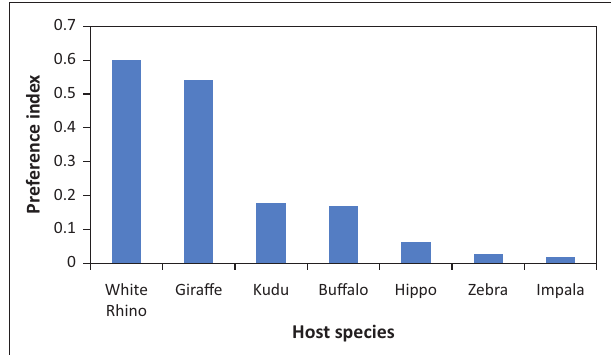
FIGURE 1: Host preferences of Red-billed and Yellow-billed Oxpeckers from both Skukuza and Shingwedzi areas in the Kruger National Park. Preference index is a